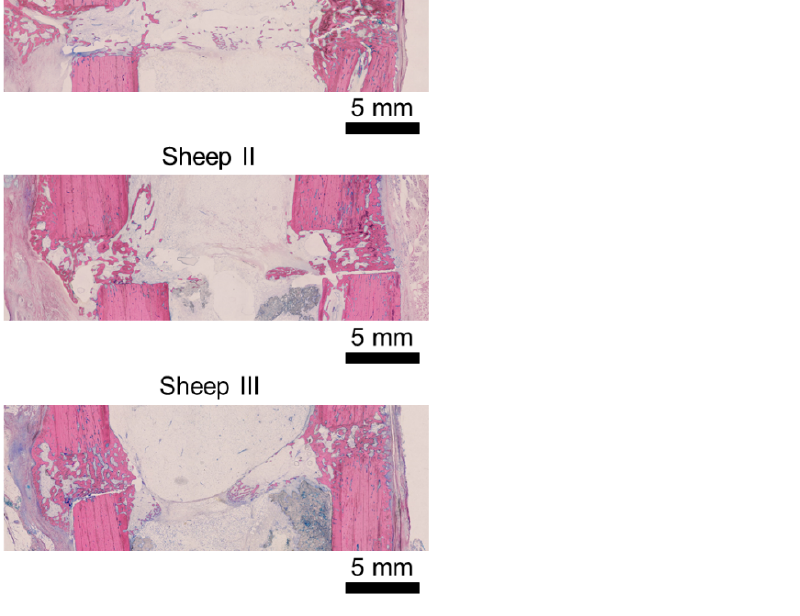
Figure 3. Histological slices displaying vital tissue in the osteotomy. No signs of avascularity nor osteonecrosis were observed. Each slice was provided with a 5 mm scale bar.